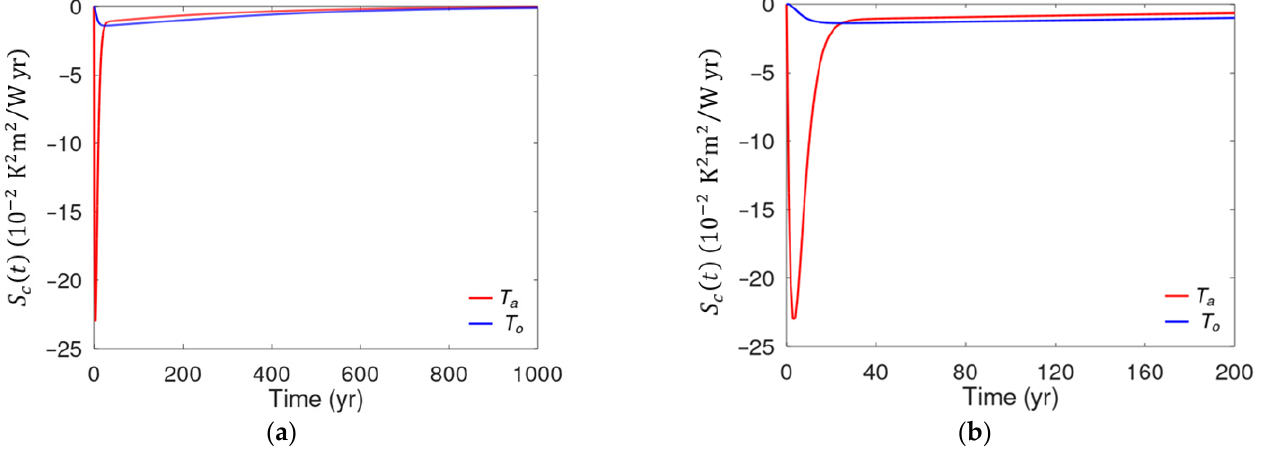
Figure 2. Sensitivities of global mean surface temperature (red line) and global mean deep ocean temperature (blue line) anomalies with respect to parameter C a , calculated for step-forcing: ( a ) over time interval of 0–1000 years, ( b ) zoomed shape over time interval 0–200 years.